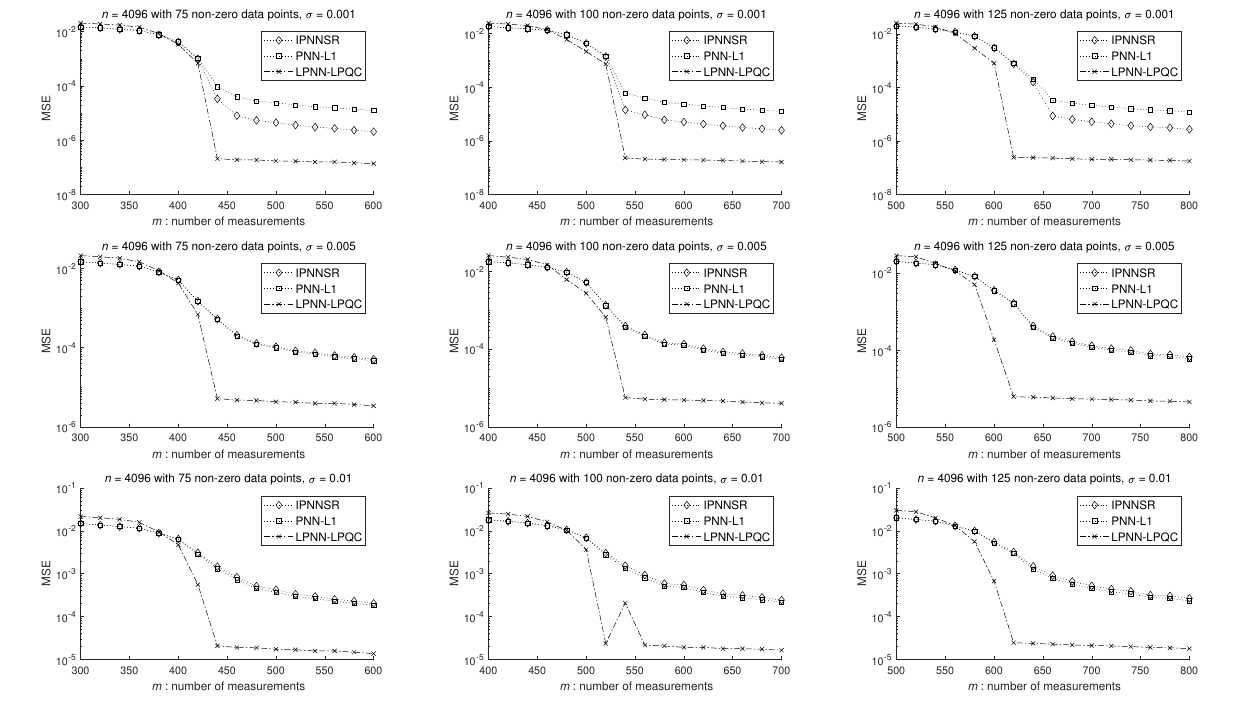
Figure 9. Comparison with other analog models on MSE, where n = 4096. For the first column, k = 75. For the second column, k = 100. For the third column, k = 125. The three rows are based on three different noise levels. The experiments are repeated 100 times using different